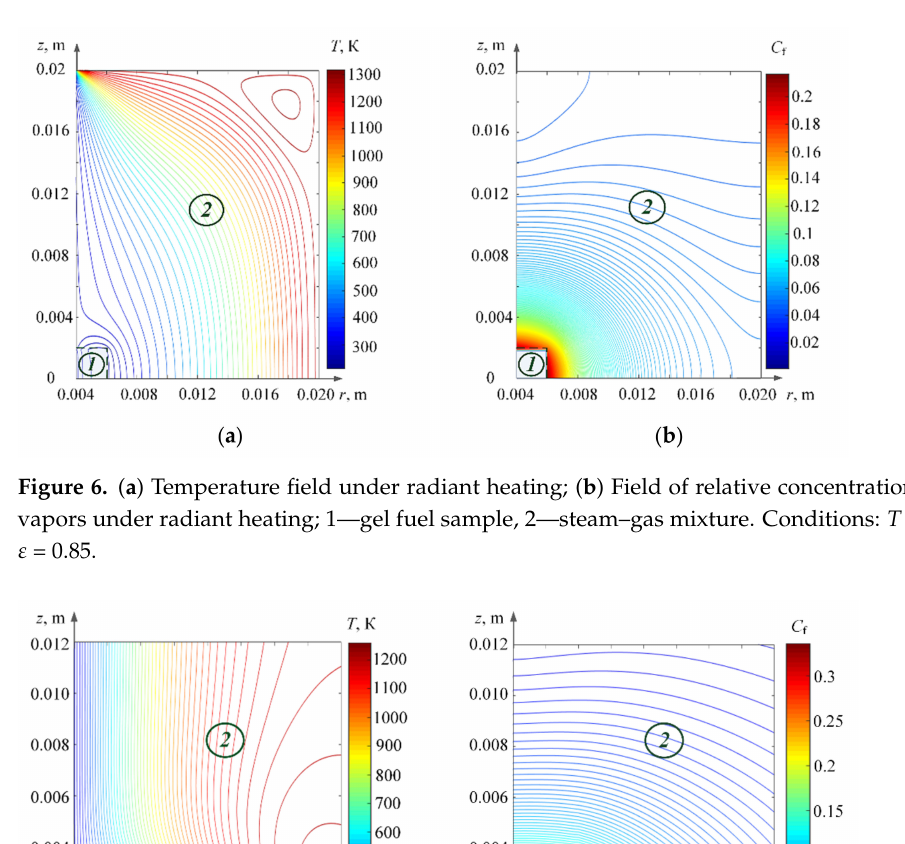
Figure 5. ( a ) Temperature field under conductive heating; ( b ) Field of relative concentrations of fuel vapors under conductive heating; 1—heated surface, 2—gel fuel sample, 3—steam–gas mixture. Heating source temperature: T = 1273 K.